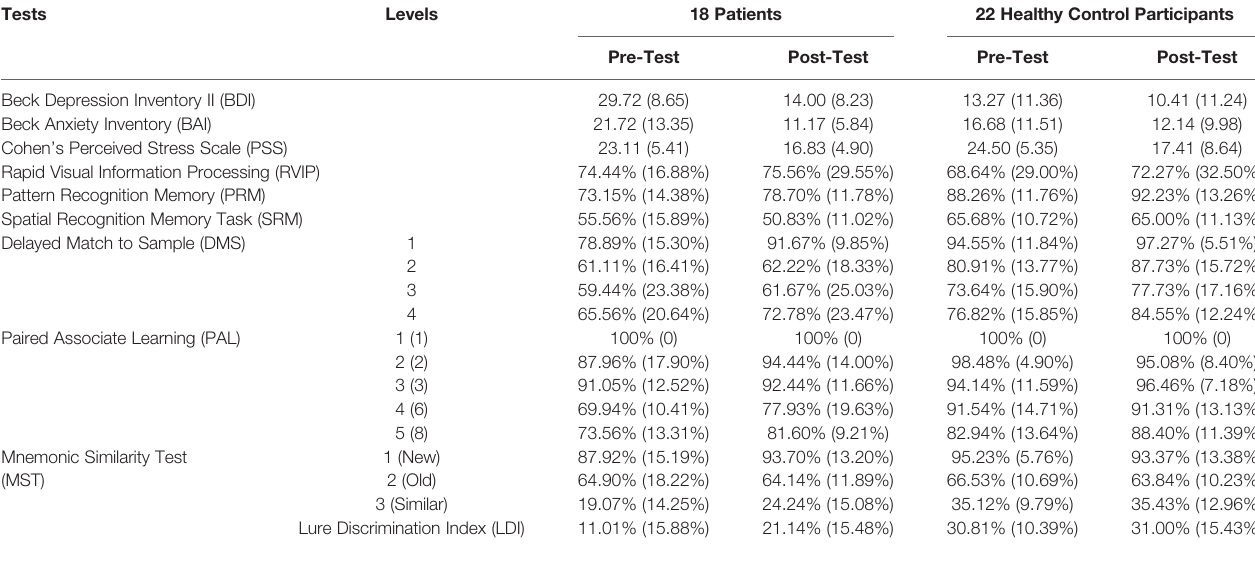
TABLE 3 | Mood Scores (averages and standard deviations) and Cognitive Test Accuracy Scores (% correct and standard